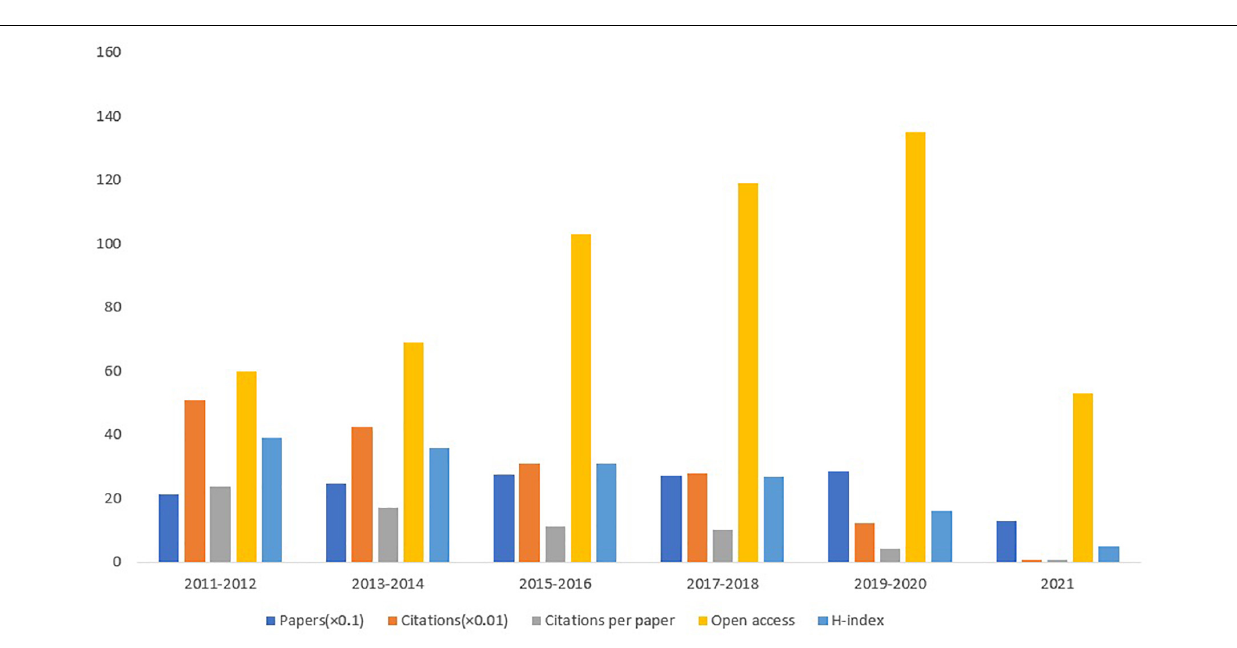
FIGURE 2 | Amounts of publications, citations, citations per paper, open access paper, H-index, and citations for each 2-year time